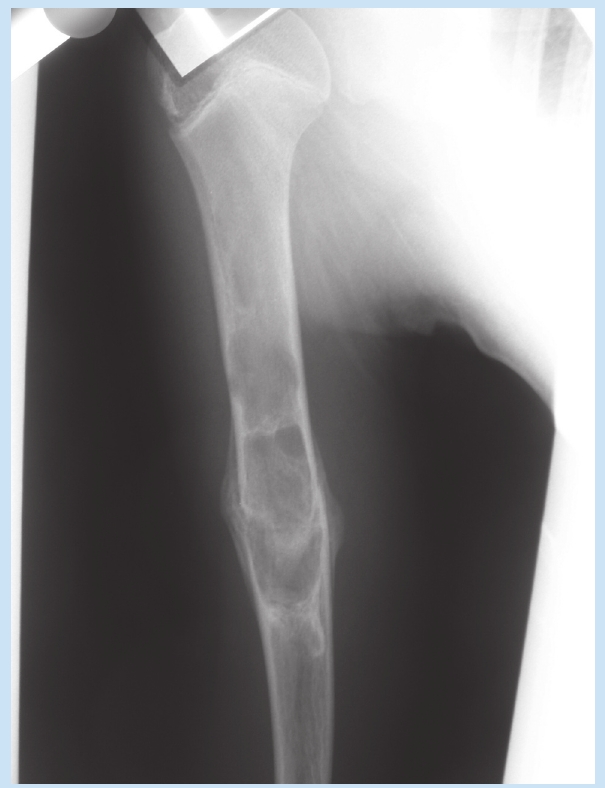
Fig. 2. In addition to the visualised pathological fracture, a ‘fallen fragment’ is demonstrated which is almost pathognomonic of a simple bone